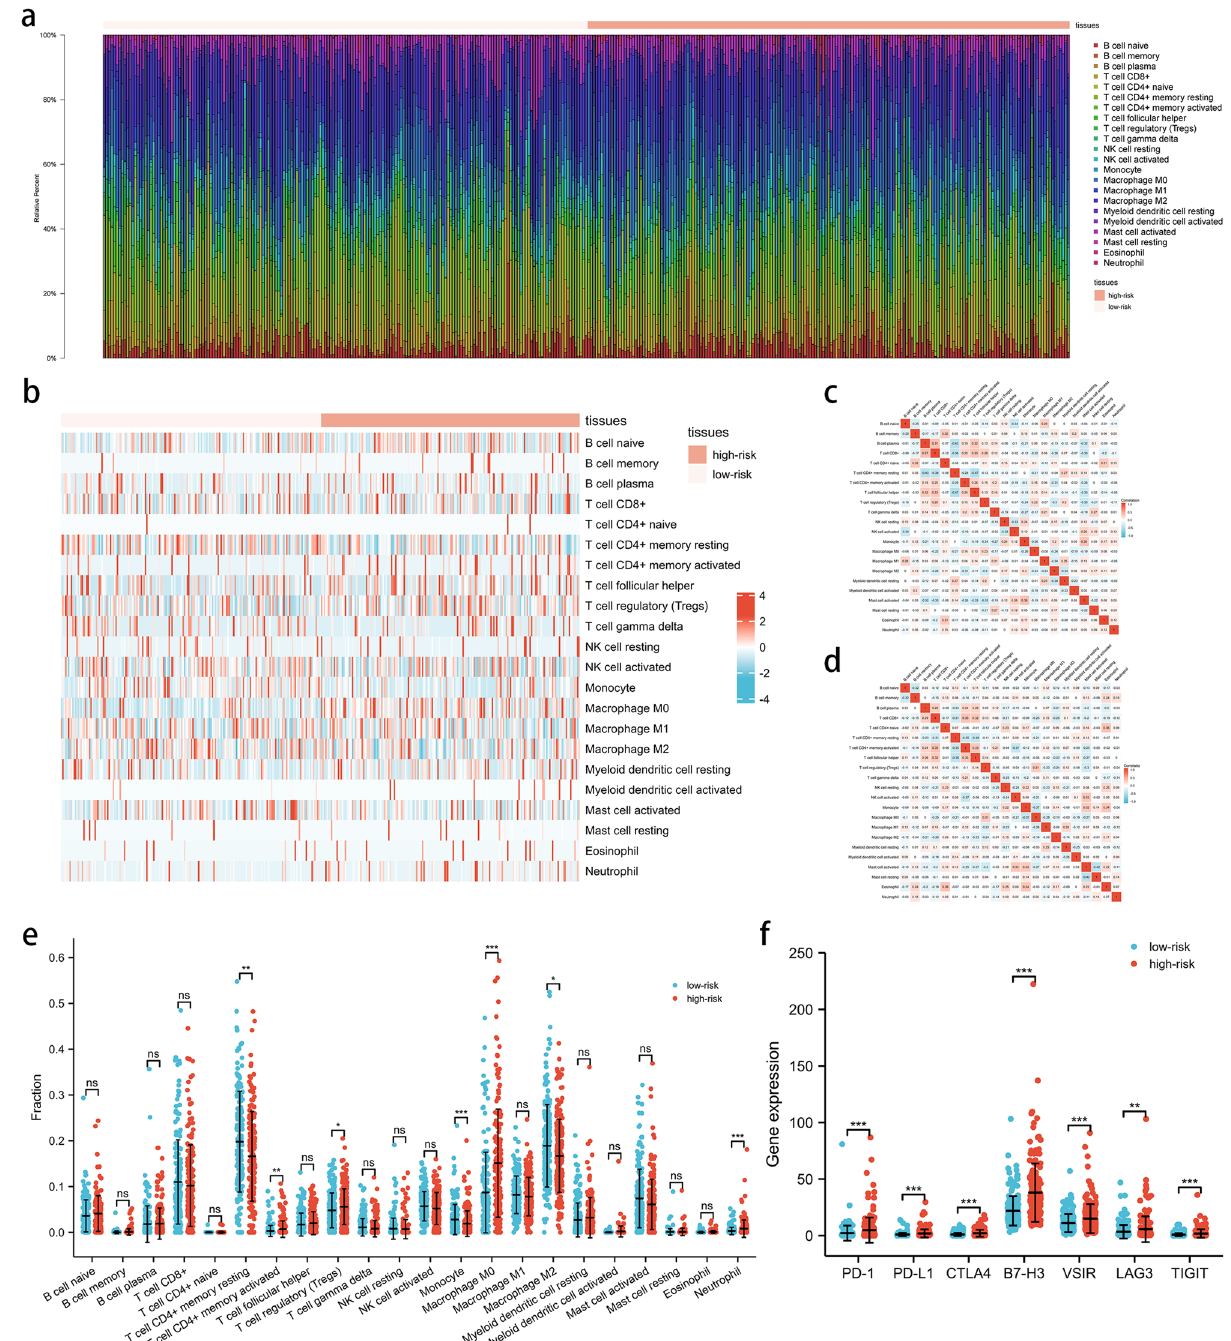
Figure 7. The interactions between pyroptosis-related lncRNA signature and immune regulation in HCC patients. ( a ) The barplot of the tumor-infiltrating cell proportions. ( b ) The heatmap of the tumor-infiltrating cell proportions. ( c ) Correlation matrix of immune cell proportions in the low-risk group. ( d ) Correlation matrix of immune cell proportions in the high-risk group. ( e ) Comparisons of immune cell proportions between the low-risk group and the high-risk group. ( f ) Comparisons of multiple immune checkpoints between the low-risk group and the high-risk group, including PD-1, PD-L1, CTLA4, B7-H3, VSIR, LAG3,